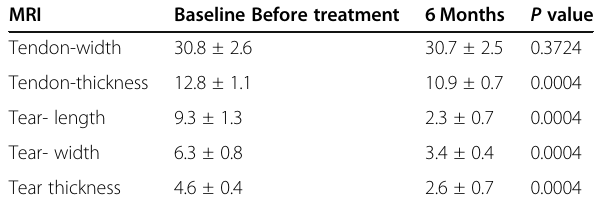
Table 3 MRI Outcomes (expressed in mm)